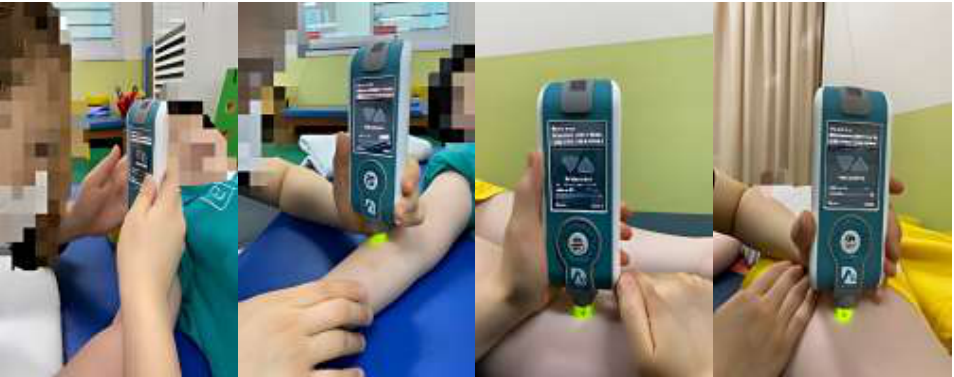
Figure 2. Muscle-tone measurements for each muscle were acquired using the MyotonPRO. Mea- surements of muscle tone.